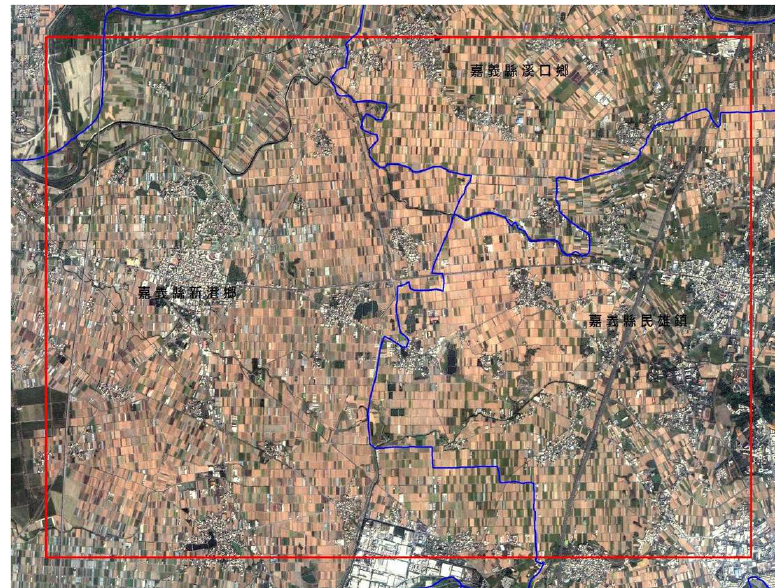
Fig. 5. Study area (Xikou